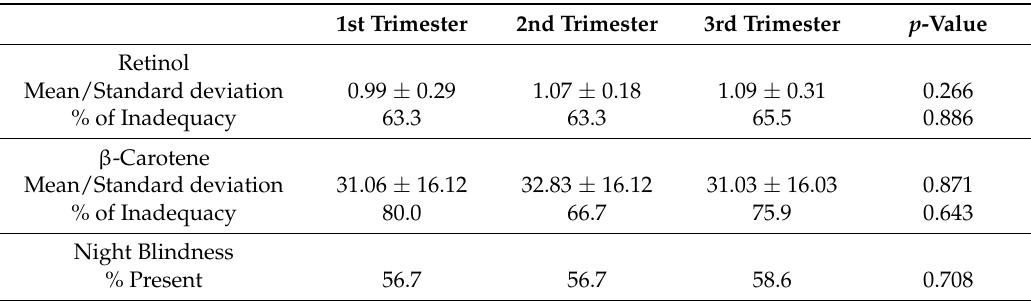
Table 1. Mean serum concentrations of retinol and β -carotene and percentage of night blindness, per trimesters of